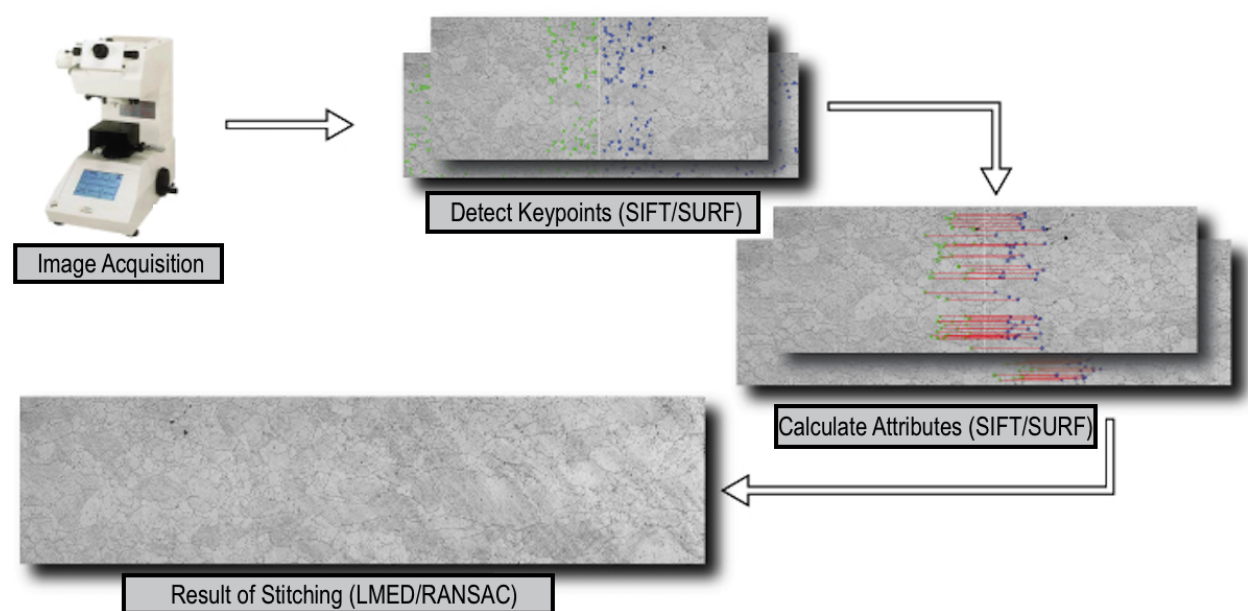
Figure 3. Steps of the process of analysis proposed through of the mosaic construction using SIFT and SURF